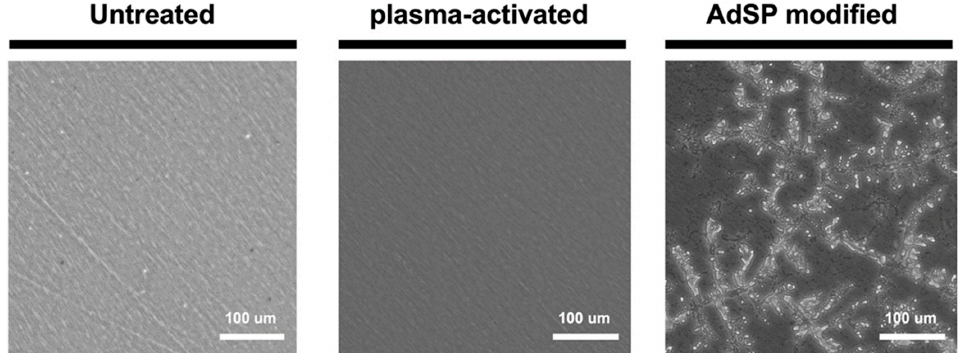
Figure 5. Surface images of the untreated non-adhesive dish, the plasma-activated dish, and the AdSP-modified dish observed by microscopy.